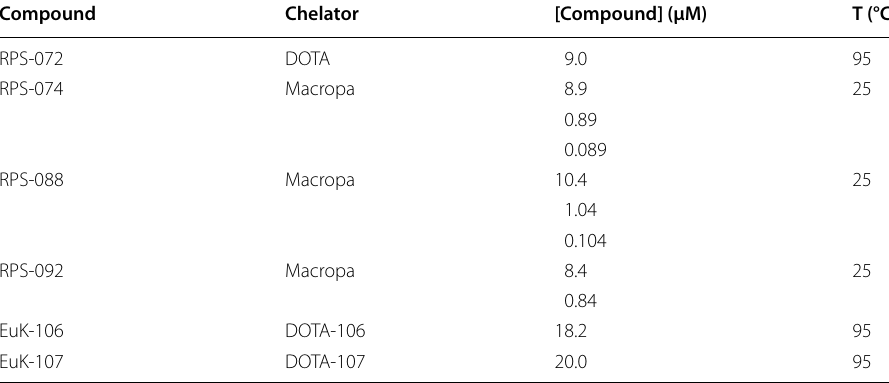
Table 1 Reaction conditions for